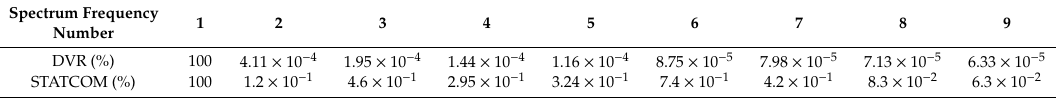
Table 6. Evaluation of load side voltage frequency spectrum for DVR and STATCOM in scenarios 5 and